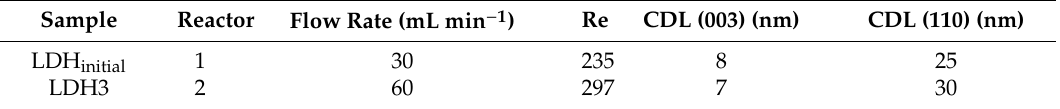
Table 6. Changes to crystal domain length (CDL) and Reynolds number in reactors 1 and 2.